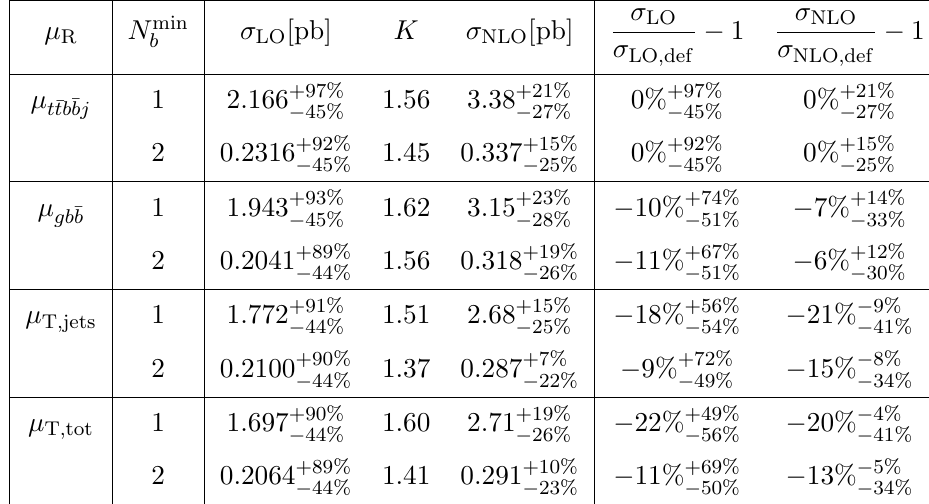
Table 4. Cross sections at LO and NLO for pp t (cid:22) tb (cid:22) bj at p s = 13 TeV. Results are shown for ! the (cid:12)ducial regions with N min = 1 and N min = 1 ( ttbj ) or N min = 2 ( ttbbj ). The acceptance j b b cuts (3.11) are applied. Four di(cid:11)erent choices of (cid:22) R as de(cid:12)ned in (3.3), (3.5){(3.7) are compared, while the factorisation scale (3.10) is used throughout. Columns 3{5 show absolute predictions at LO and NLO, as well as the usual correction factor K = (cid:27) NLO =(cid:27) LO . Uncertainties given in percent correspond to seven-point factor-two variations of (cid:22) R and (cid:22) F . Columns 6 and 7 show the relative di(cid:11)erences between LO and NLO cross sections, respectively, based on the default (cid:22) R = (cid:22) t (cid:22) tb (cid:22) bj and the other dynamical scales. As central values we report ratios obtained with the nominal values of the various scales, while lower (upper) values correspond to the minimum (maximum) of (cid:27) ( (cid:24) R ; (cid:24) F ) =(cid:27) 1, where seven-point variations are restricted to the numerator. The (N)LO (N)LO ; def (cid:0) reported cross sections have been computed with Monte Carlo statistical uncertainties at the level of three permille at NLO and below one permille at